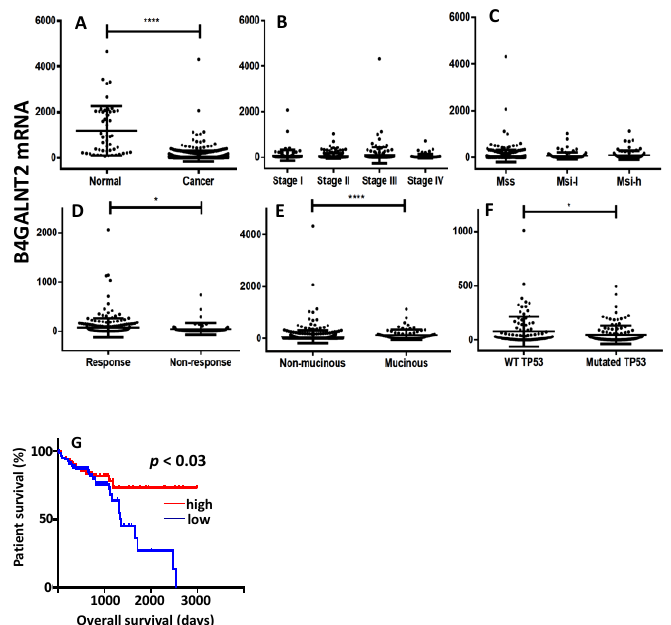
Figure 2. The Cancer Genome Atlas (TCGA) data. ( A ) Expression level of B4GALNT2 mRNA in normal mucosa and colorectal cancer (CRC) specimens. ( B – F ) Expression of B4GALNT2 mRNA in CRC specimens grouped according to stage ( B ), microsatellite stability status ( C ), response to therapy ( D ) subtypes ( E ), and TP53 mutation ( F ). ( G ) Kaplan–Meier survival curves of patients grouped in the groups of high expressers (15th upper percentile, red) or no expressers (15th lower percentile, blu) of mRNA B4GALNT2 expression. MSS: microsatellite stable; MSI-l: microsatellite instable-low; MSI-h: microsatellite instable-high.